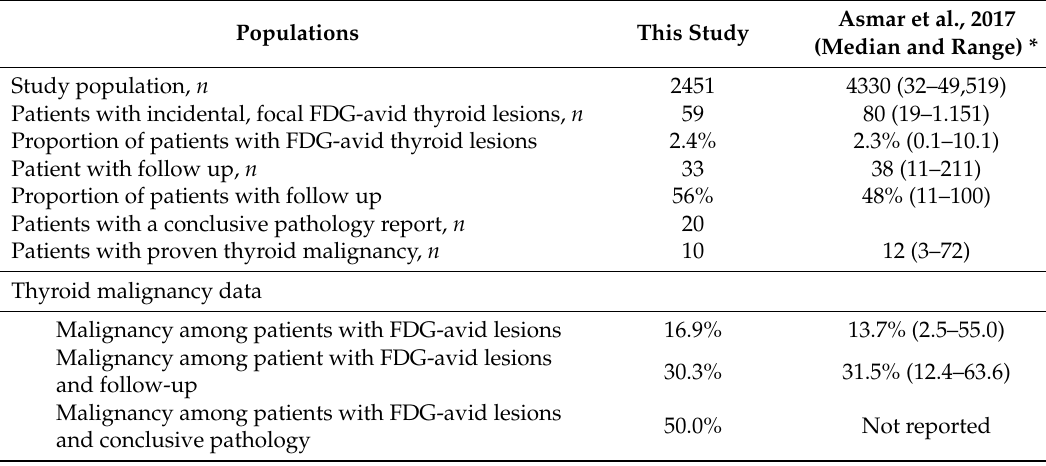
Table 2. Main findings of this study compared to summary data from 32 retrospective papers presented in a recent systematic review by Asmar et al.